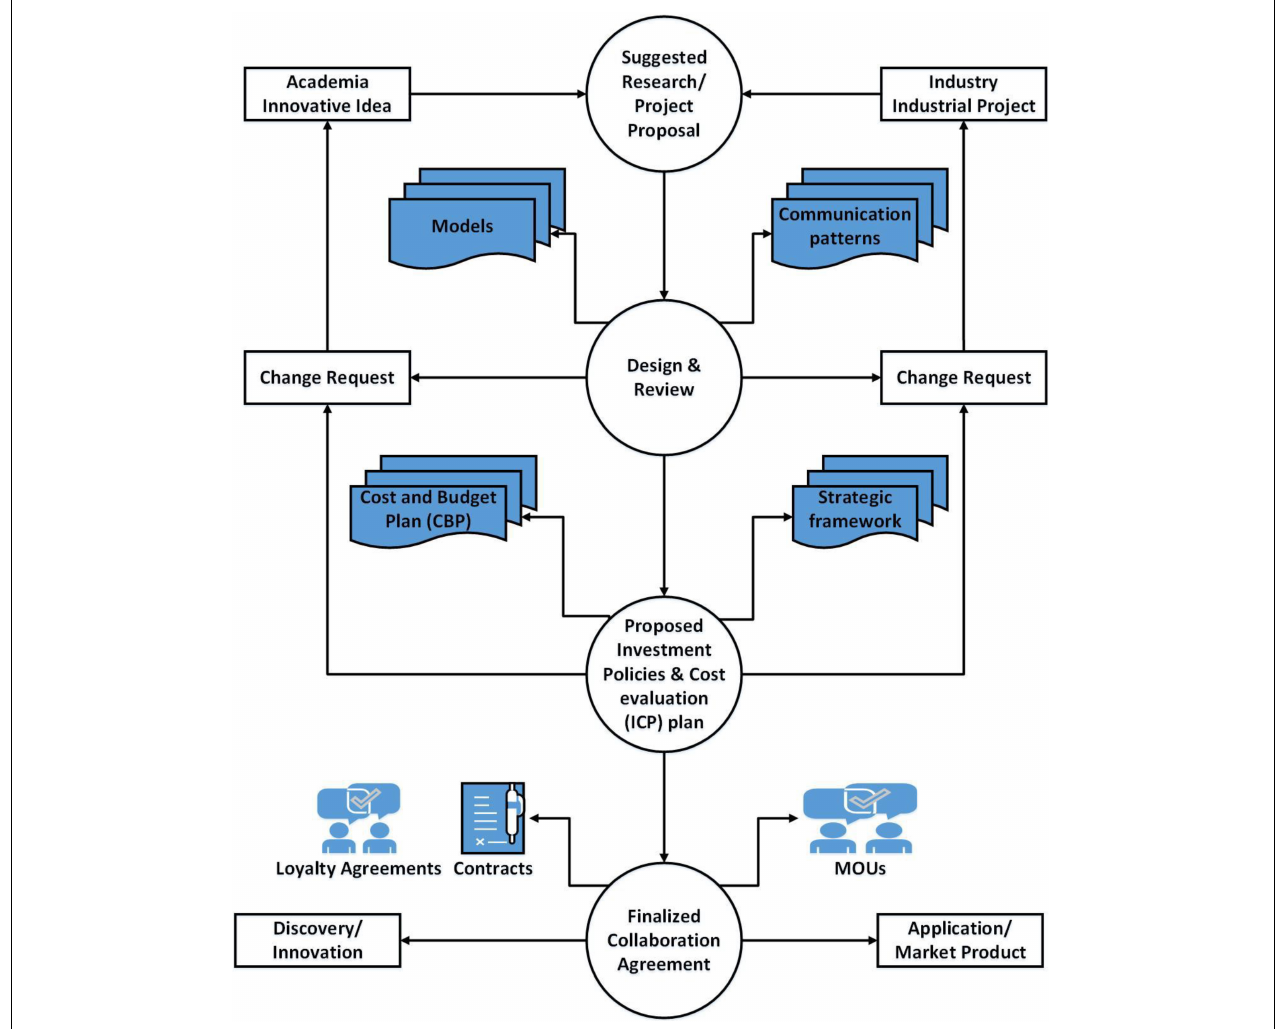
FIGURE 2 | Academia industry collaboration (AIC) engineering process architecture.